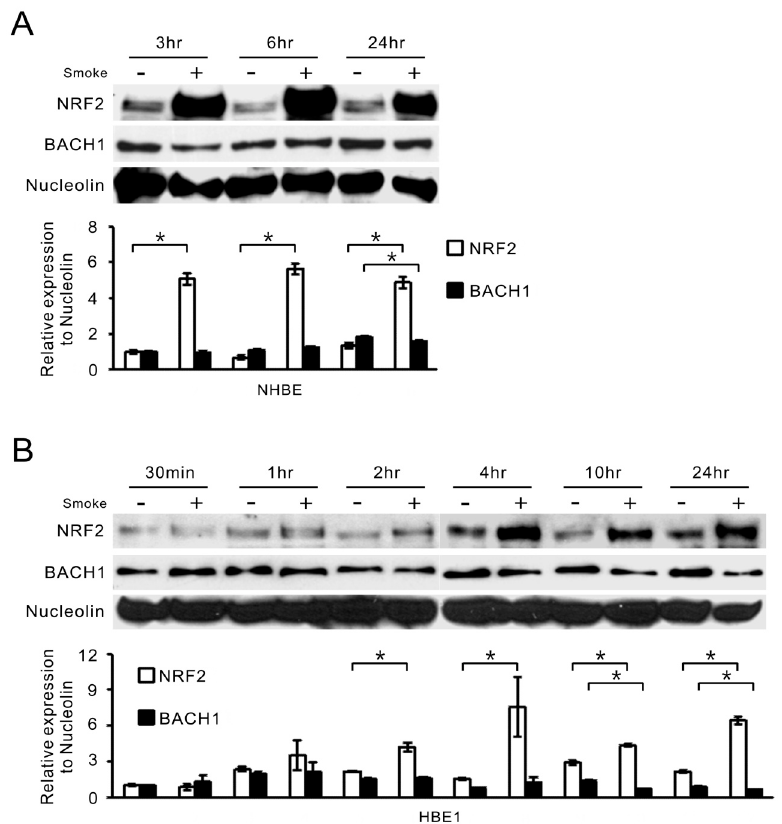
Figure 3. Cigarette smoke alters the nuclear levels of NRF2 and BACH1 in NHBE and HBE1 cells. ( A , B ) NHBE ( A ) and HBE1 ( B ) cells were collected at indicated time points after smoke exposure and extracted for nuclear proteins. The NRF2 and BACH1 protein levels in the nucleus were examined by Western blot assays ( top ). Nucleolin was used to normalize the protein loading in the SDS-PAGE gel. The mean results for densitometric scans of three blots from three separate experiments are shown in the bottom panel as fold relative to that of untreated NHBE cells at 3 h ( A ) or untreated HBE1 cells at 30 min ( B ). * p < 0.05 ( n = 3; mean ± S.D.).